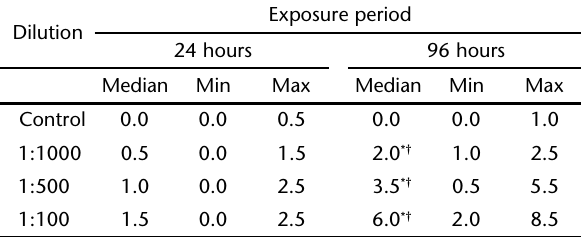
Table I. Micronuclei in the erythrocytes of H. reidi exposed to different diesel water soluble fraction dilutions (DWSF: 1:1000, 1:500 and 1:100) for 24 and 96 hours. n = 7 for each combination of dilution and time.